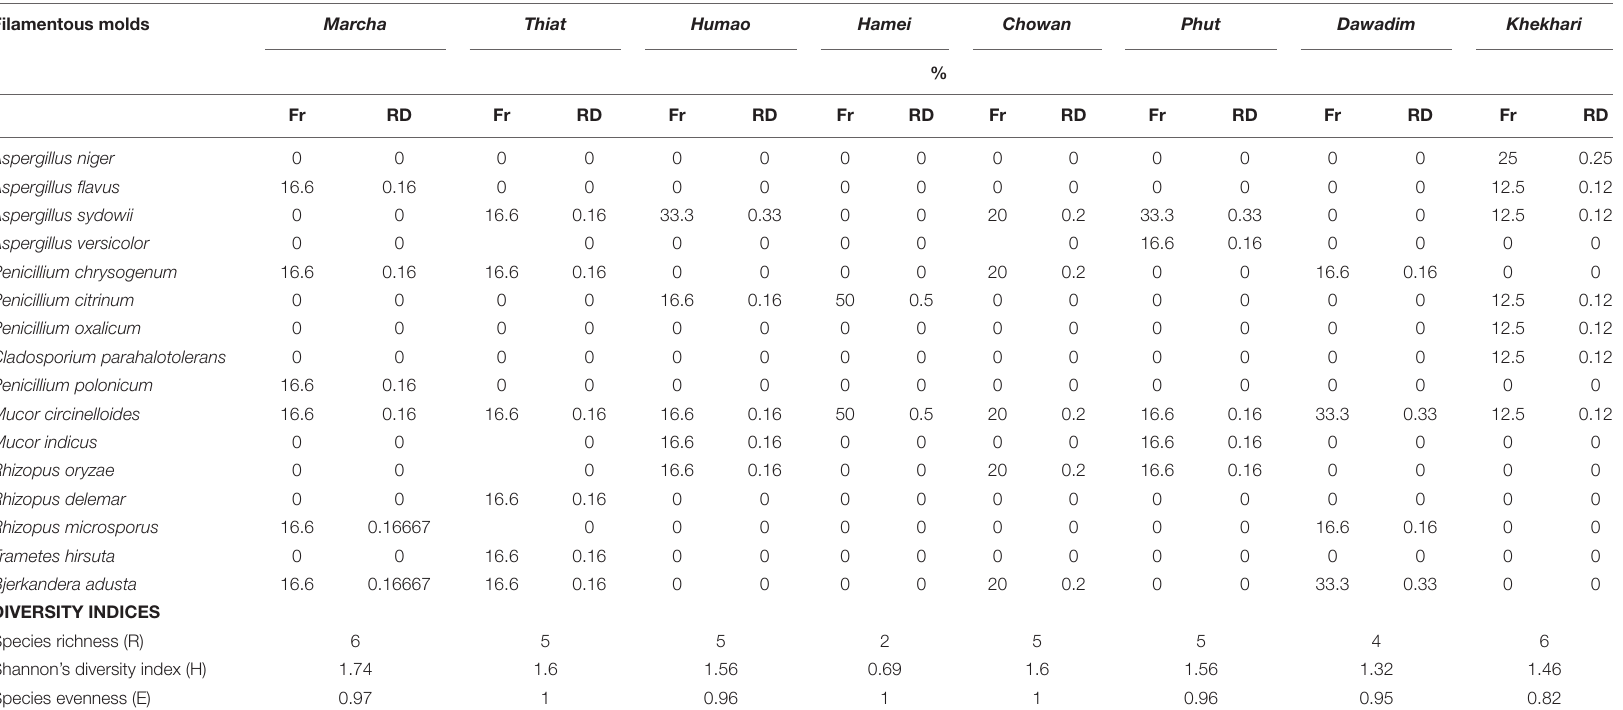
TABLE 3 | Frequency, density, and diversity indices of filamentous molds observed in dry starters from North East India. Filamentous